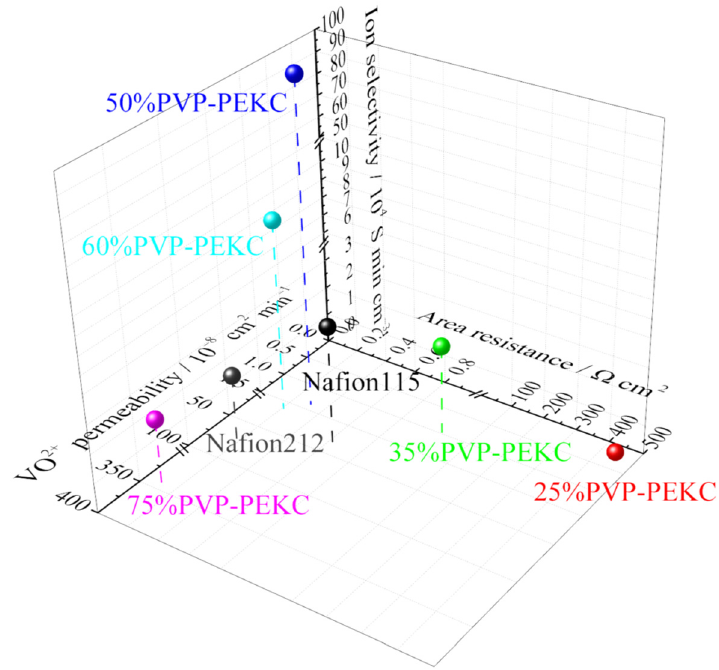
Figure 8. Ion selectivity of various membranes after immersing in 3 M H 2 SO 4 at RT.